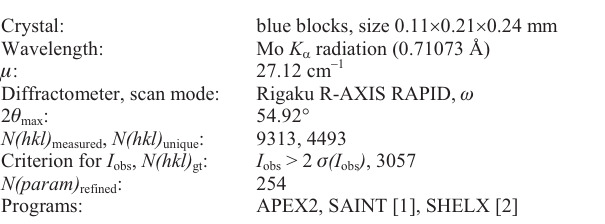
Table 1. Data collection and handling.